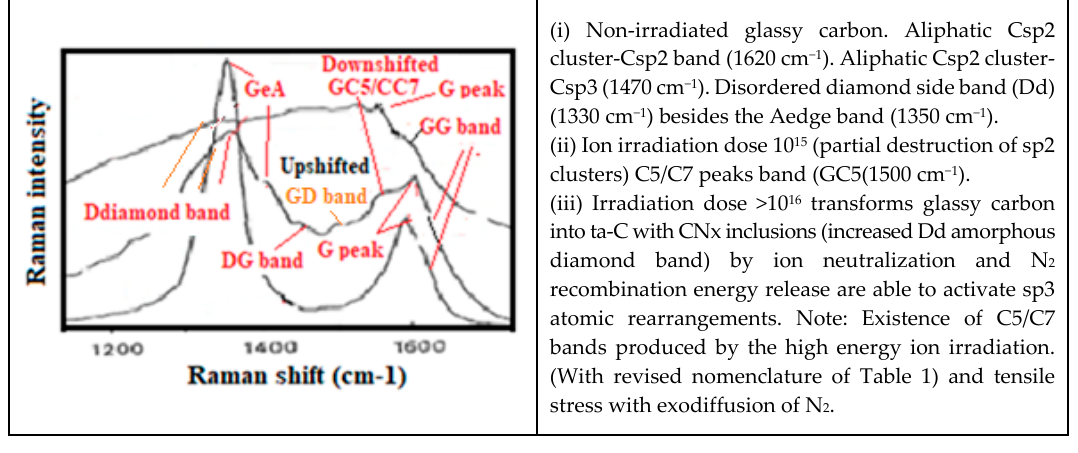
Figure 3. Transformation of graphene into H6 diamond with electric field polarization perpendicular to the graphene plane [25]. H6 diamond.: Stack of chair shape carbon hexagonal rings (sp3 bonded to four others). Raman frequency at~1325 cm − 1 according to McNamara et al. [116] and Spear et al. [189] and Phelps et al. [190]. Most carbon material types have more or less a semiconducting electronic band structure and metallic CNT are in fact semimetal materials with valence band and conduction band [27,134,149– 151,191]. Therefore, atomic rearrangement in consequence of more energetic electronic activation and formation of internal electric field with different decay time of activated electrons and holes (higher energy quantum electronic activation) can appear in many solid-state systems.